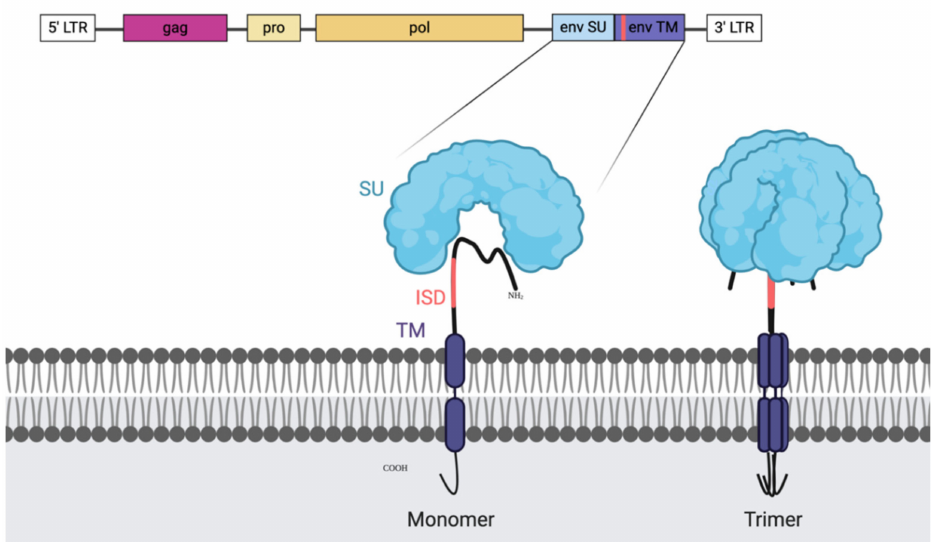
Figure 1. Illustration of endogenous retroviral genes and the envelope (ENV) protein with the immune suppressive domain (ISD). The retroviral genome organisation is shown on the top with the genes enclosed by the long terminal repeats (LTRs). First, in pink, we can find the group specific antigen ( GAG) , next to it, in light yellow, is the protease ( PRO ) and after the polymerase ( POL ). Highlighted is the ENV gene and the generated protein as a monomer (left) and as the natural trimer (right). The ISD domain is recognisable in coral and is a part of the transmembrane domain (TM). It is partially shielded in the folded trimer by the surface unit (SU) which makes it a di ffi cult, but not unreachable target and it is present on most retroviral ENV